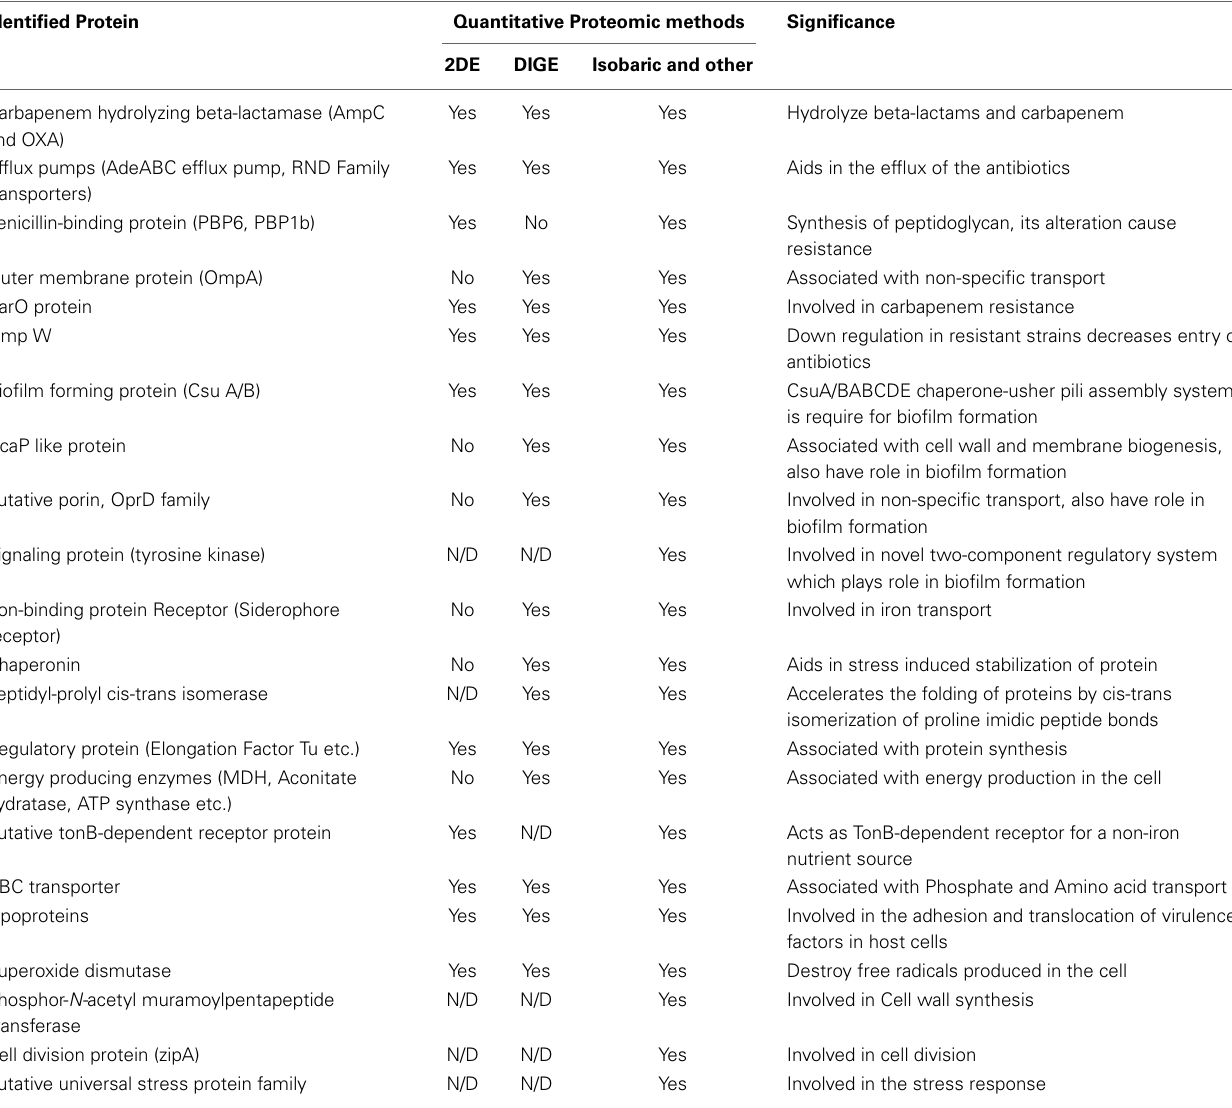
Table 1 | Differentially expressed proteins identified in the carbapenem resistance strain as compared to sensitive strain of A. baumannii using various quantitative proteomic approaches (Siroy et al., 2006; Kwon et al., 2009; Vashist et al., 2010; Cabral et al., 2011; Lee et al., 2011; McQueary and Actis, 2011; Yun et al., 2011; Tiwari et al.,